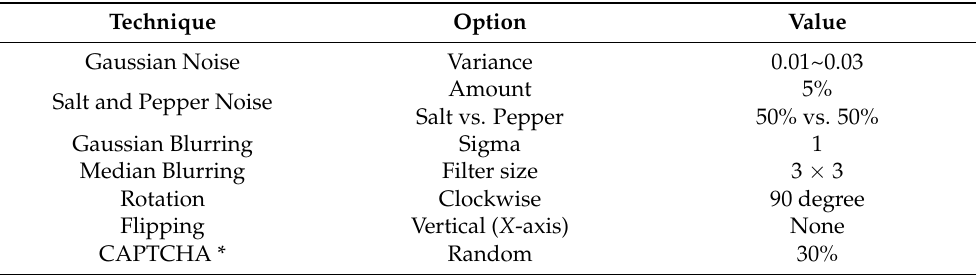
Table 6. Techniques and examples to circumvent the OCR systems.